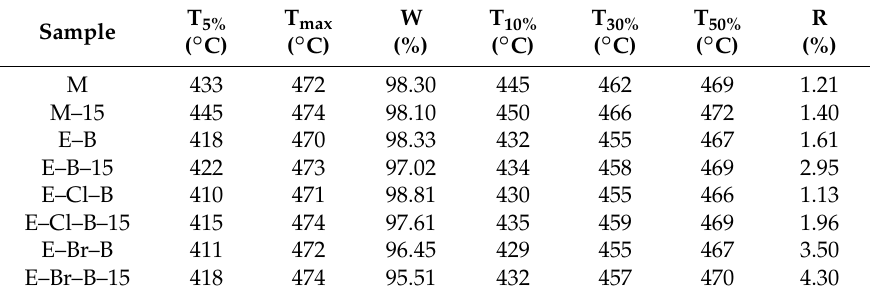
Table 6. TGA results for the thermal degradation of EPDM/butyl rubber